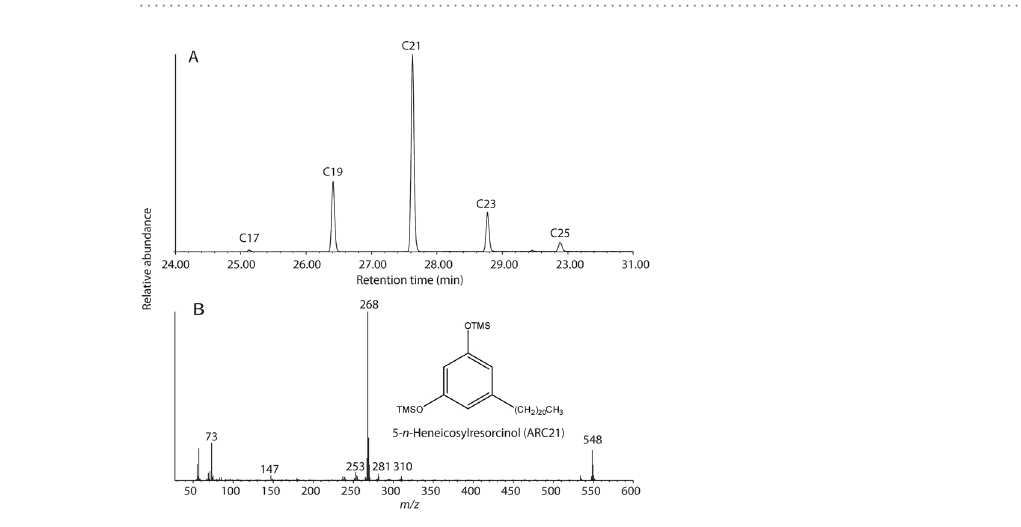
Figure 2. Partial total ion current chromatogram of lipid extracts from the residue (#137337) and the wooden artefact (#137338 and #137339) of total lipid extracts (left) analysed as TMS ethers and acid extracts (right) analysed as methyl esters using a DB-5 ms column. Alkylresorcinols in TLE of the residue are reported in red.